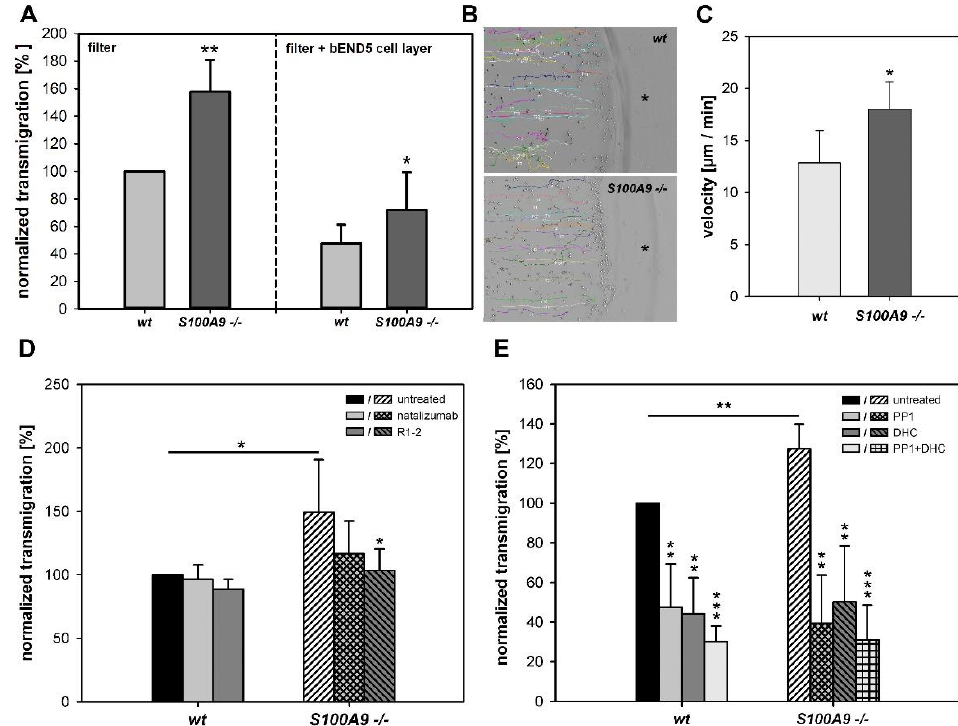
Figure 8. S100A8/S100A9 expression altered transmigration rates. Two chamber filter-based transmigration assays of the wildtype (wt) and S100A9 -/- BMCs in the absence ( A left and D , E ) or presence ( A right) of a bEND5 endothelial cell layer ( n = 5). S100A8/S100A9-deficient cells showed increased numbers of transmigrated cells after 4 h of migration. ( B ) Migration tracks of isolated BMCs analyzed from the 2D migration assays showed no differences in cell orientation behavior between the wildtype and S100A9-deficient cells during chemotaxis toward the source of the chemoattractant (asterisk) ( n = 3). ( C ) S100A9-deficient BMCs showed a significantly higher overall migration speed compared to the wildtype cells ( n = 3; total number of tracked cells = 69 wildtype and 57 S100A9 -/-). ( D ) The addition of natalizumab (10 µg/mL) or R1-2 (10 µg/mL) reduced the number of transmigrated S100A9-deficient cells to the wildtype levels, whereas the wildtype cells were not affected ( n = 4). ( E ) Dependency of the transmigration rates on Src (10 µM) and Syk (2 µM) activities. Addition of either inhibitor (PP1/DHC) or the combination of both resulted in a significant decrease in transmigrated cells and reduced the otherwise higher transmigration of S100A9-deficient cells to the wildtype levels ( n = 3, mean ± SD; *** p < 0.001; ** p < 0.01; * p < 0.05. ( D , E ) All data were normalized to the untreated wildtype cells set to 100%, and the significance levels (asterisks) refer to the comparison to the corresponding untreated cells if not otherwise indicated.